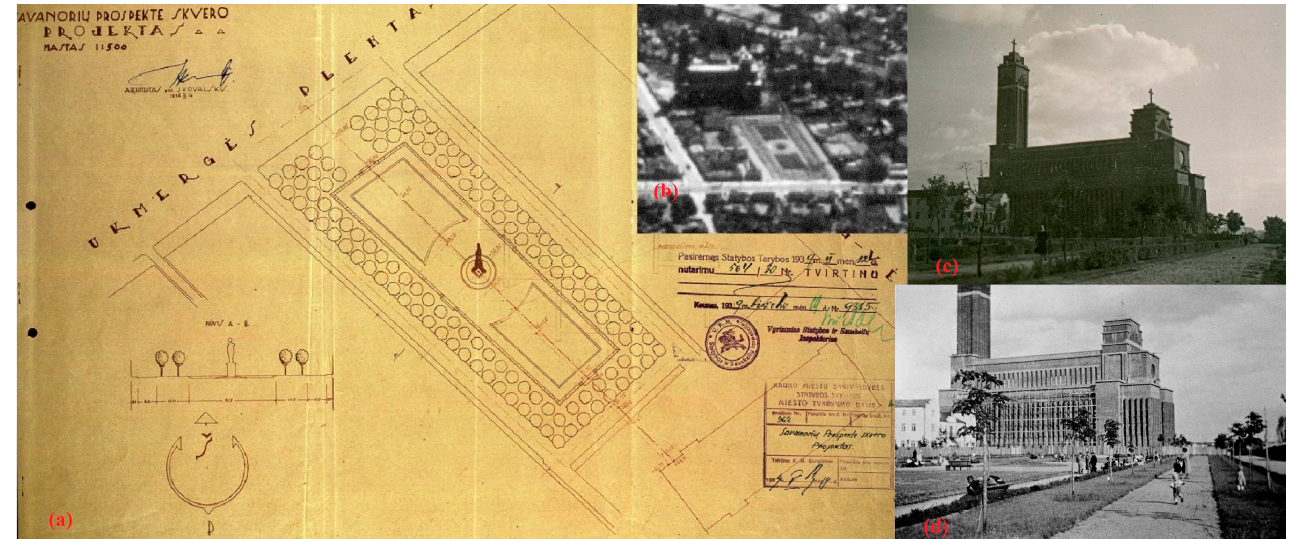
Figure 8. The square. ( a ) The project plan, 1938 (source: Kaunas Regional State Archives); ( b ) aerial photo from 1939 (source: Kaunas Regional State Archives); ( c , d ) 1940 (source: Lithuanian Central State Archives).